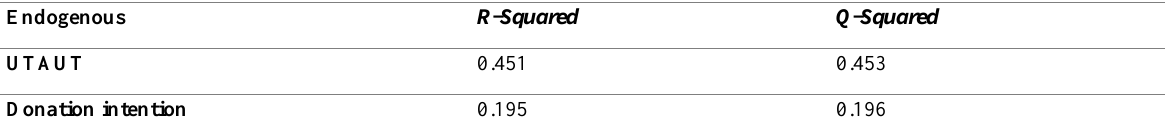
Table 3: Model Goodness of Fit